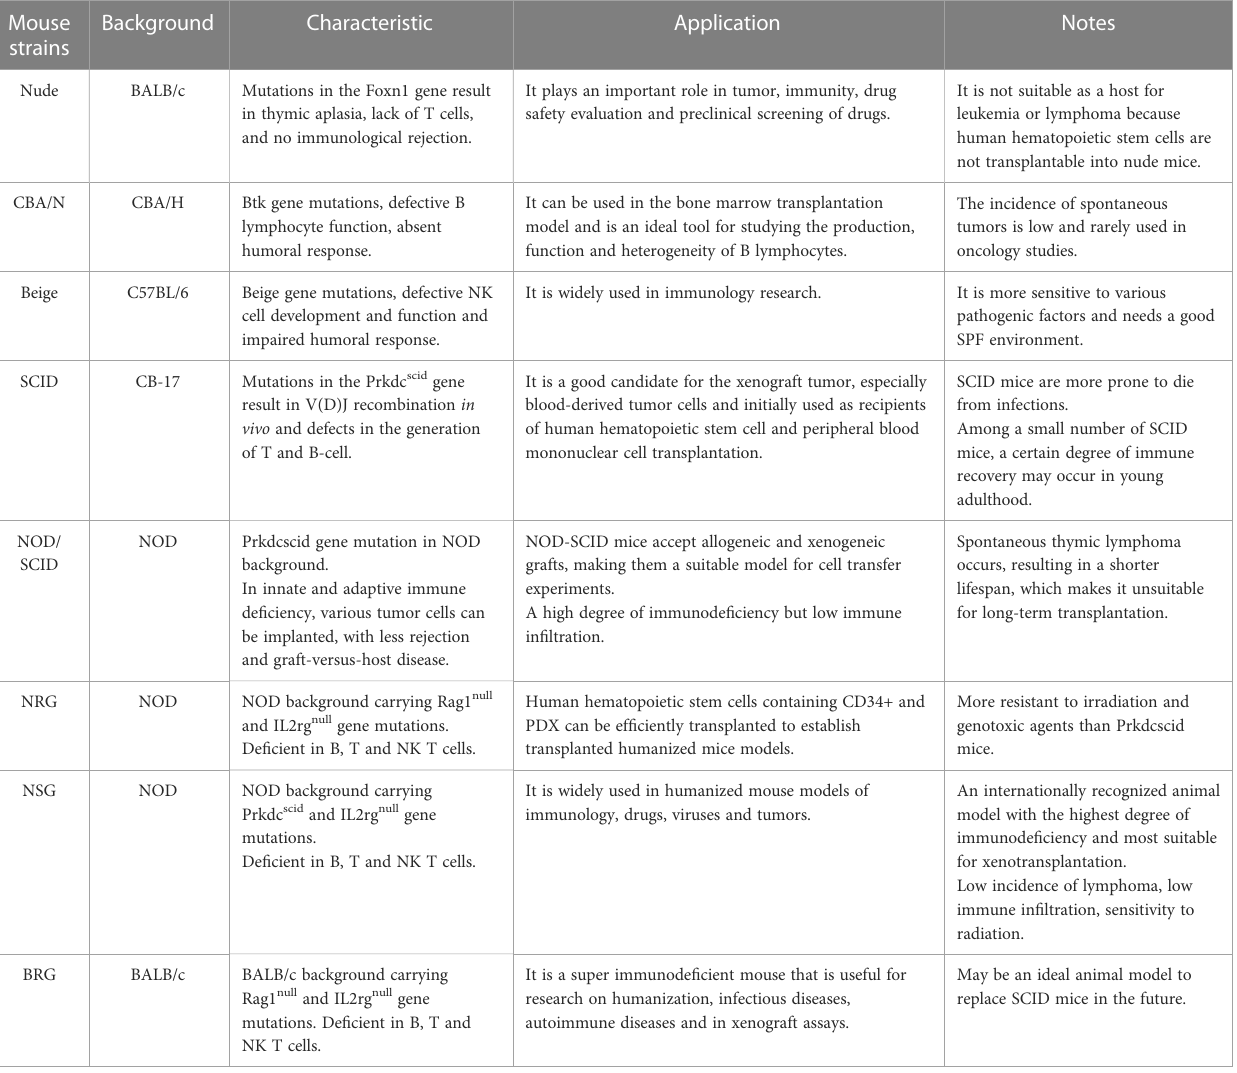
TABLE 1 Characteristics and application of common immunode fi cient mice. Mouse strains